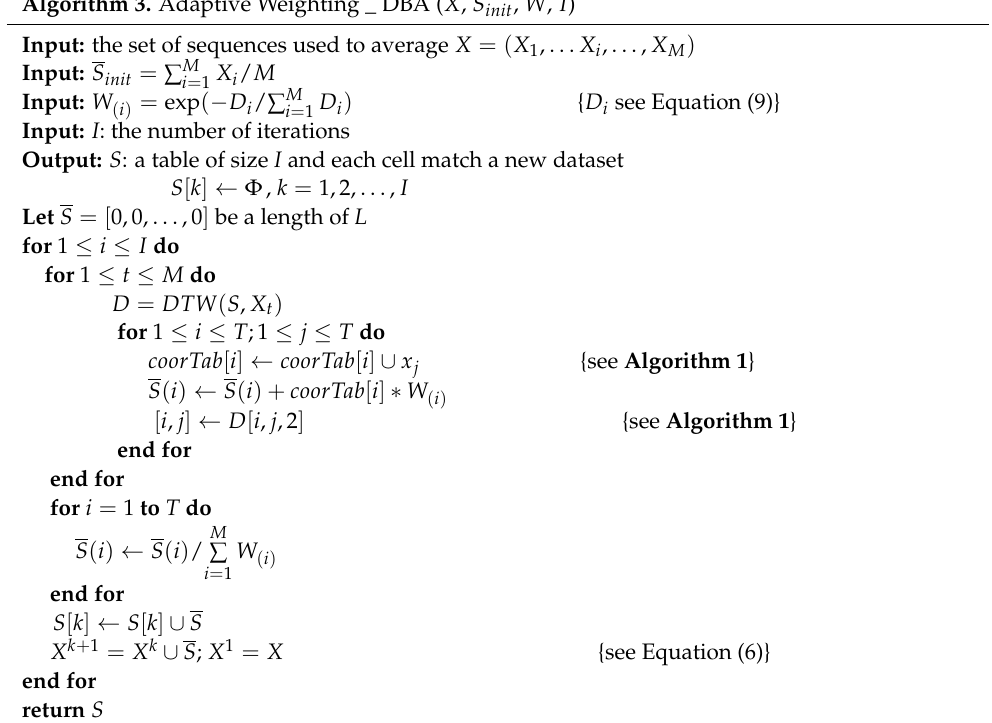
Algorithm 3. Adaptive Weighting _ DBA ( X , S init , W , I